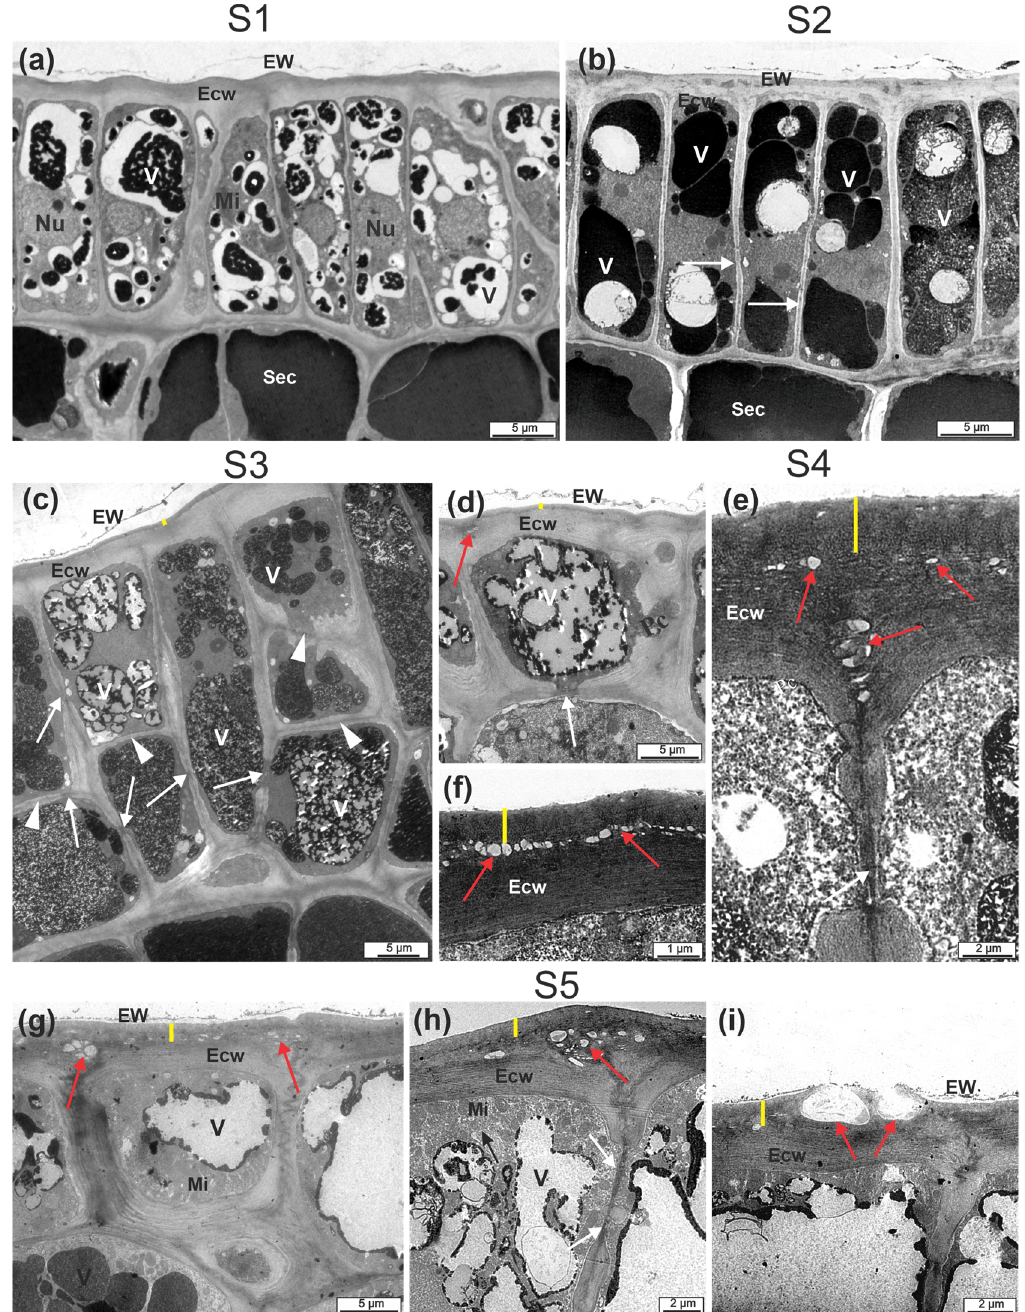
Figure 6. Electron transmission micrographs of the skin of CCP 76 cashew pseudofruits in five stages (S1, S2, S3, S4, and S5). S1 ( a ), S2 ( b ), S3 ( c ), S4 ( d – f ) and S5 ( g – i ). ( a ) Uniseriate epidermis and subepidermal cells with vacuoles filled with an electron-dense content. ( b ) Taller cells and more filled vacuoles; plasmodesmata in the anticlinal walls. ( c ) Biseriate epidermis with a thicker outer periclinal wall and vacuole with a granular content. In stages S4 ( d – f ) and S5 ( g – i ), the delimitation between the cuticle and the more evident cell wall is observed. A loose arrangement of the microfibrils of the external wall is observed, along with the presence of vesicular-looking structures when the content was released on the surface ( i ). Red arrows = spaces or vesicles; white arrows = plasmodesmata. Cuticle (Cu) = yellow dash, Ecw = external cell wall, EW = epicuticular wax, Mi = mitochondria, Nu = nucleus, Sec = subepidermal cell, V = vacuole.